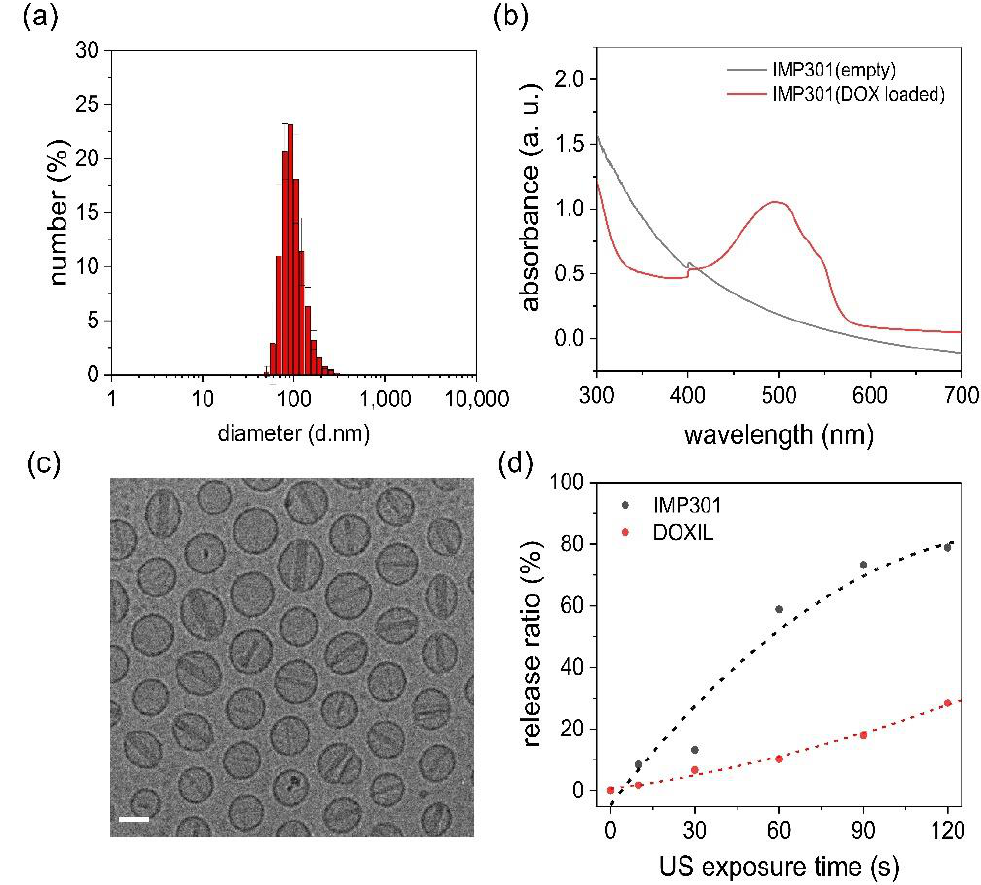
Figure 1. Characterization of IMP301. ( a ) Size distribution of IMP301, ( b ) absorbance spectrum of empty IMP301 (gray line) and doxorubicin (DOX)-loaded IMP301 (red line), ( c ) cryo-TEM image of IMP301 (scale bar = 50 nm), ( d ) the release behavior of IMP301 (black dots) and DOXIL (red dots) depends on ultrasound irradiation time.